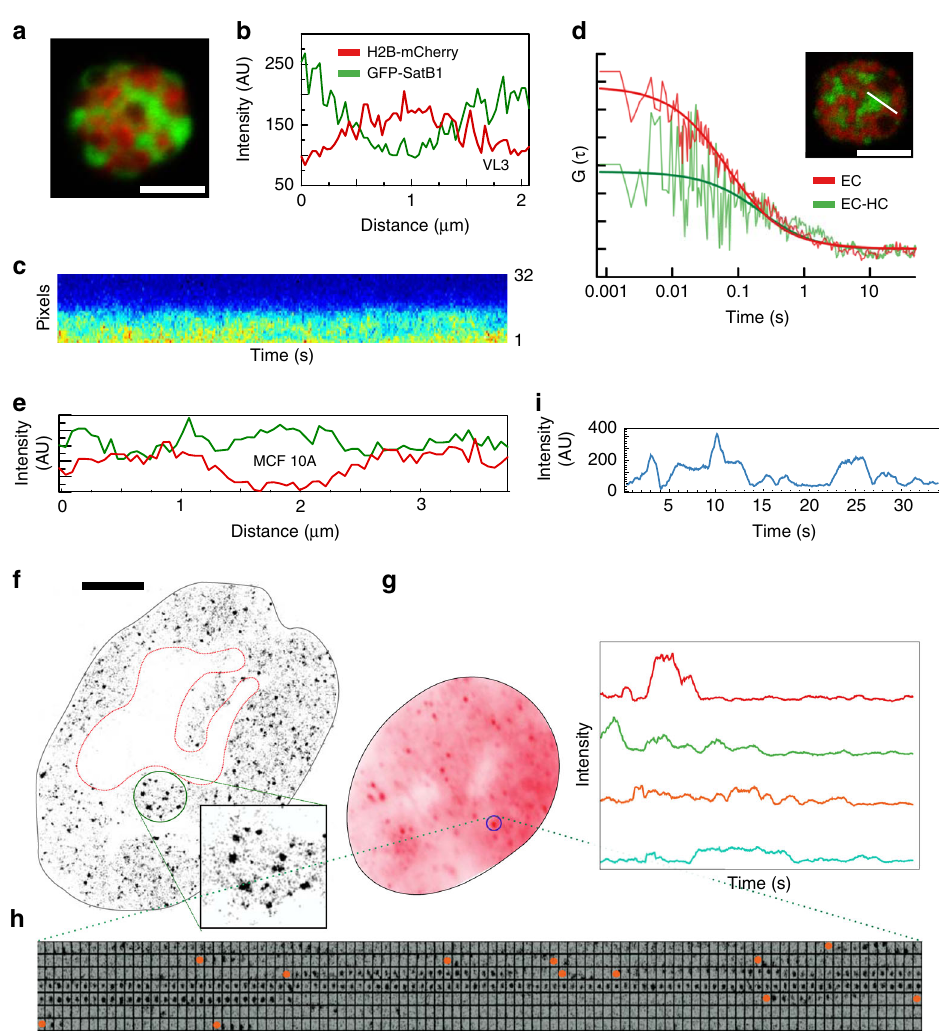
Fig. 1 High resolution spatiotemporal analysis of SatB1 binding. a A VL3 3M2 thymocyte Satb1-eGFP knockin cell line co-expressing core histone H2B- mCherry shows the classic cage pattern. b Satb1-eGFP and H2B-mCherry pro fi le along a line bisecting the thymocyte nucleus. c, d A 3.2 µ m-line bisecting a Satb1 cage and an adjacent heterochromatin is scanned repeatedly with a pixel dwell time of 6.3 µ s (32 pixels) and a line time of 0.47 ms. c A fl uorescence intensity carpet generated by repeated scanning over time where the pixels are along y axis and time is along x axis. d The autocorrelation function is calculated pixel-by-pixel along the scanned line. The two autocorrelation functions shown are for one-pixel columns that reside either in the cage or at the cage-heterochromatin boundary. e Exogenous Satb1 distribution in MCF-10A cells does not show any stark difference between euchromatic and heterochromatic compartments. f Super-resolution image of Satb1 in the MCF-10A nucleus reconstructed from all localizations obtained over ~1000 frames. g Properties of the Satb1 interaction hotspots. The summed intensity of 700 frames (spanning 35 s) for a cell expressing eGFP fusion of native Satb1. Note discrete spot like structures scattered throughout the nucleus. h A 7 × 100 matrix of one region of interest (marked by circle in f )